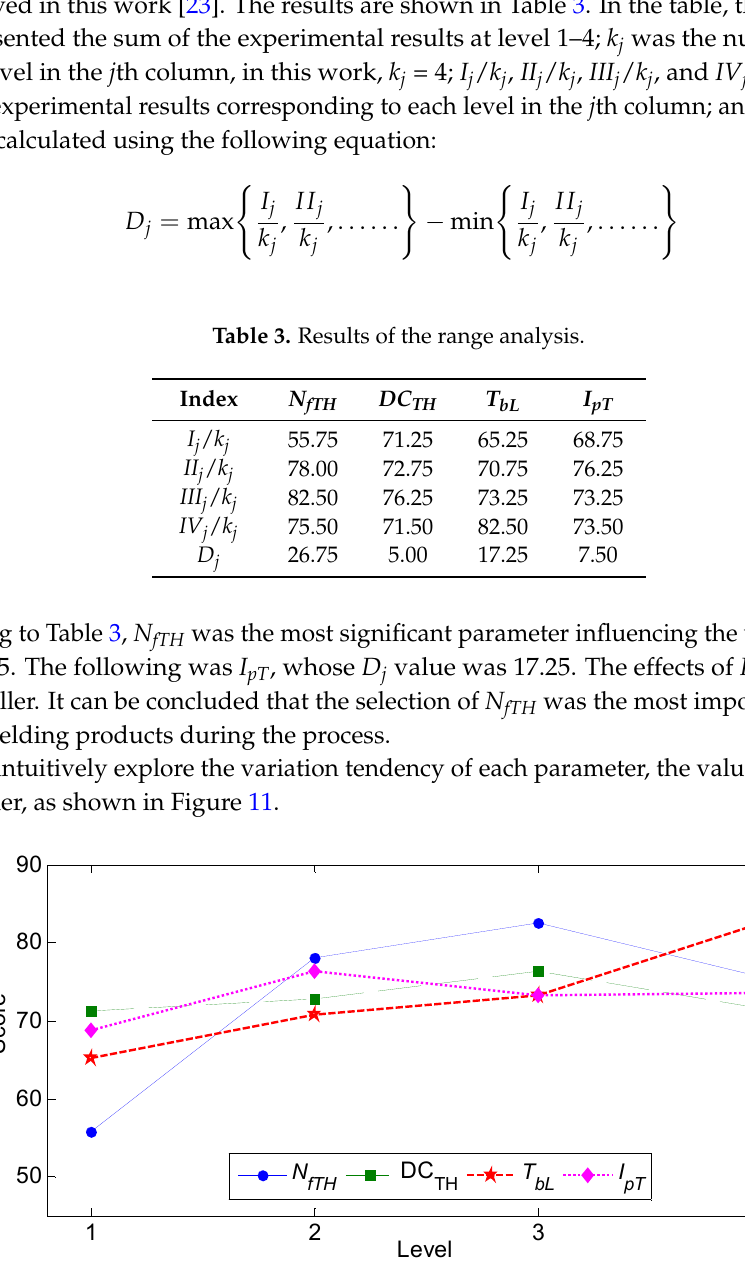
Figure 11. Parameter effect curves.